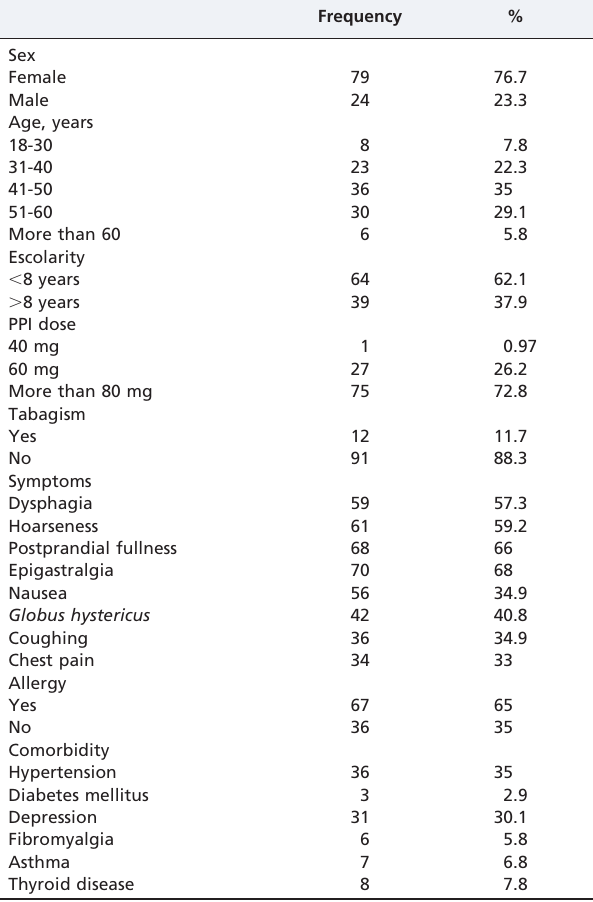
Table 1 - Study population characteristics PPI: proton pump inhibitor.